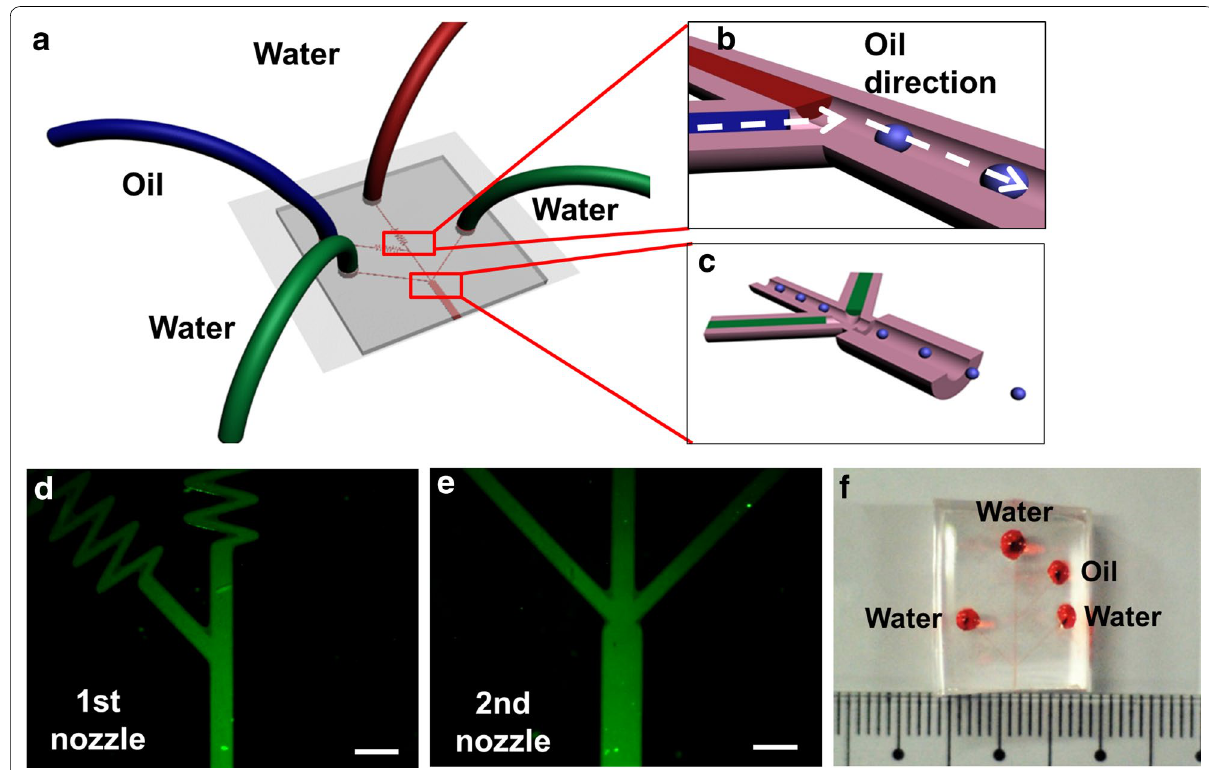
Fig. 1 Design and fabrication of the microfluidic dual-nozzle device. Schematic of the dual-nozzle device ( a ), magnified schematic of the first ( b ), and second nozzle ( c ). Microscope images of the fabricated first ( d ), and second nozzle ( e ). For illustration purposes, the channels are filled with fluorescein solution. Scale bars are 200 µm. Photograph of the fabricated PDMS device, for illustration purposes the channels are filled with red dye ( f